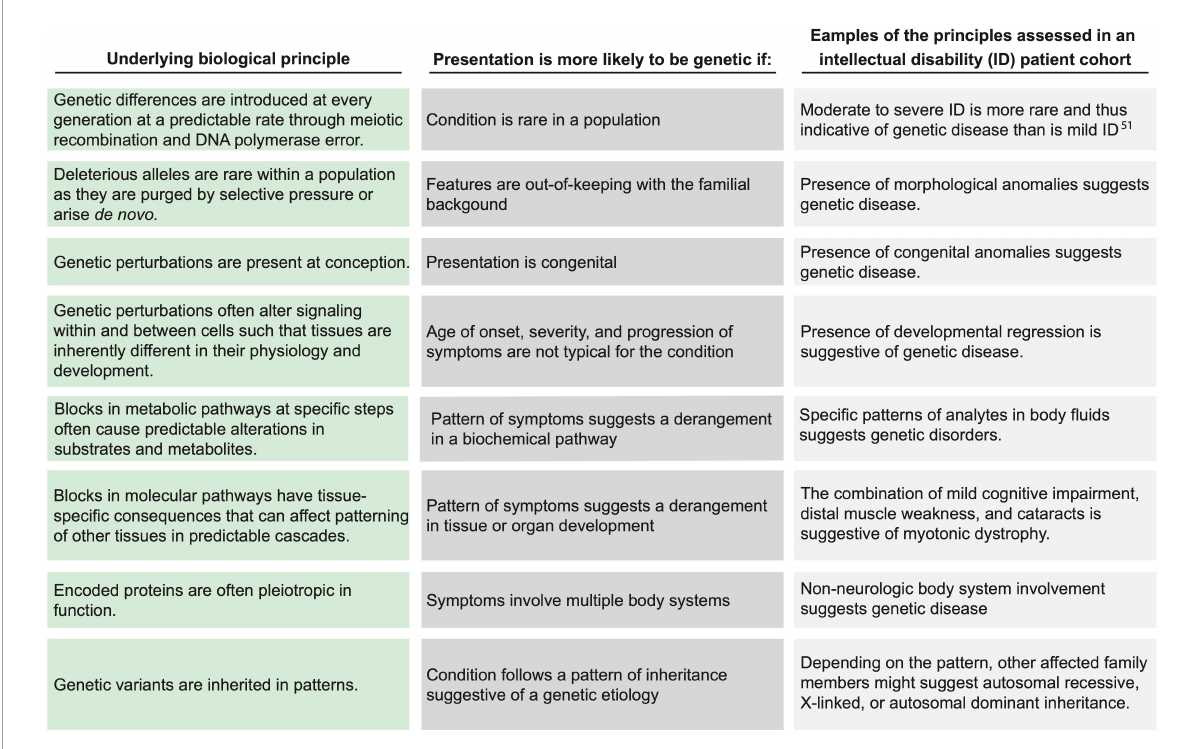
FIGURE1 Applying biological principles to assess the likelihood of genetic disease. Within the biologic principles of disease (left column) , certain clinical attributes (center column) increase the likelihood of a genetic disease. The (right column) lists examples of clinical representations of such biological principles for individuals with intellectual disability. Each example may be representative of more than one biological principal. Drawn from current understanding of evolutionary biology, these principles were synthesized and defined by the Provincial Medical Genetics Program (PMGP) clinical genomic specialists (CGSs), and the examples were drawn from their clinical practices.